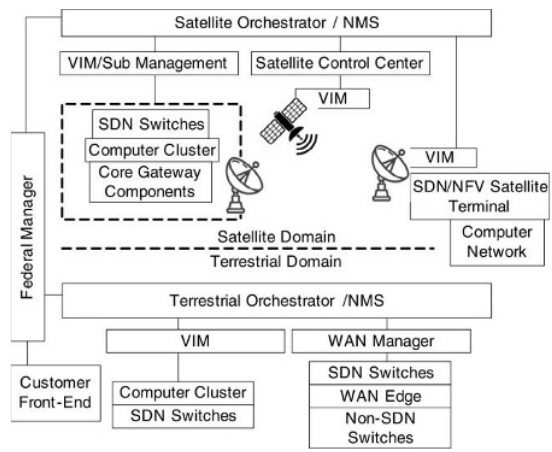
Fig. 3. Satellite-enable SDN/NFV